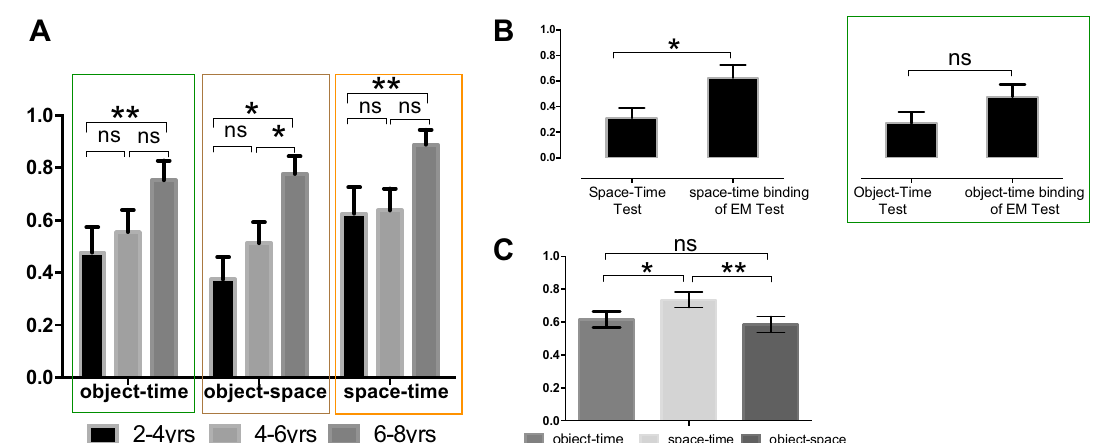
Figure 1. Enhancement of space-time binding in the EM Test. ( A ) The graphs present the accuracy means for object-time, object-space, and space-time binding components of the EM Test in the TD sample divided by age- groups (2–4; 4–6; 6–8 yrs). ( B ) Presents the accuracy means of Space-Time Test compared to space-time binding scores of the EM Test (left), and Object-Time Test compared to object-time binding of the EM Test for 2–4-years old children (right). ( C ) Presents the distribution of each EM binding components across all TD subjects. ns; p < 0.05 *p < 0.01 **.